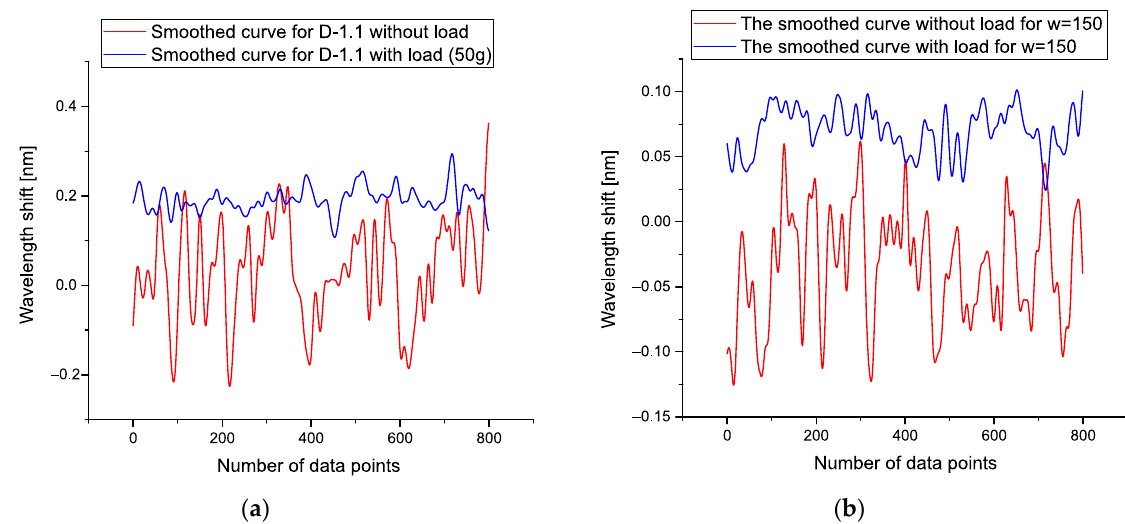
Figure 5. ( a ) Results of the application of POLS for w = 150 and detector D-1.1; ( b ) the same results for D-2.2 at w = 150.